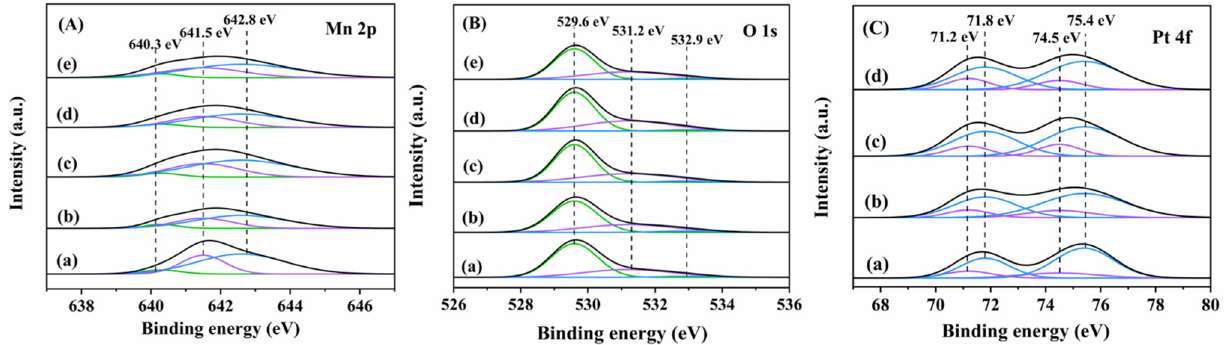
Figure 5. ( A ) Mn 2p, ( B ) O 1s, and ( C ) Pt 4f XPS spectra of (a) α -MnO 2 , (b) 0.93Pt/ α -MnO 2 , (c) 0.91Pt- 0.5rGO/ α -MnO 2 , (d) 0.94Pt-1.0rGO/ α -MnO 2 , and (e) 0.92Pt-2.0rGO/ α -MnO 2 . Table 3. Surface element compositions and H 2 consumption of the As shown in Figure 5B, O 1s XPS spectra of the samples were split into three compo- nents at BE = 529.6 eV, 531.2 eV, and 532.9 eV, which were due to the surface lattice oxygen (O latt ), adsorbed oxygen (O ads ), and hydroxyl or adsorbed water [26], respectively. As shown in Table 3, the O ads /O latt molar ratio decreased in the sequence of 0.94Pt-1.0rGO/ α - MnO 2 (0.57) > 0.92Pt-2.0rGO/ α -MnO 2 (0.55) > 0.91Pt − 0.5rGO/ α -MnO 2 (0.53) > 0.93Pt/ α - MnO 2 (0.50) > α -MnO 2 (0.45). The O ads /O latt molar ratio increased obviously after Pt load- ing. Moreover, the molar ratio of O ads /O latt further increased after loading of rGO, which exhibits the same changing trend as the Mn 3+ /Mn 4+ molar ratio. Among all of the samples, 0.94Pt-1.0rGO/ α -MnO 2 possessed the highest O ads /O latt molar ratio, therefore the highest